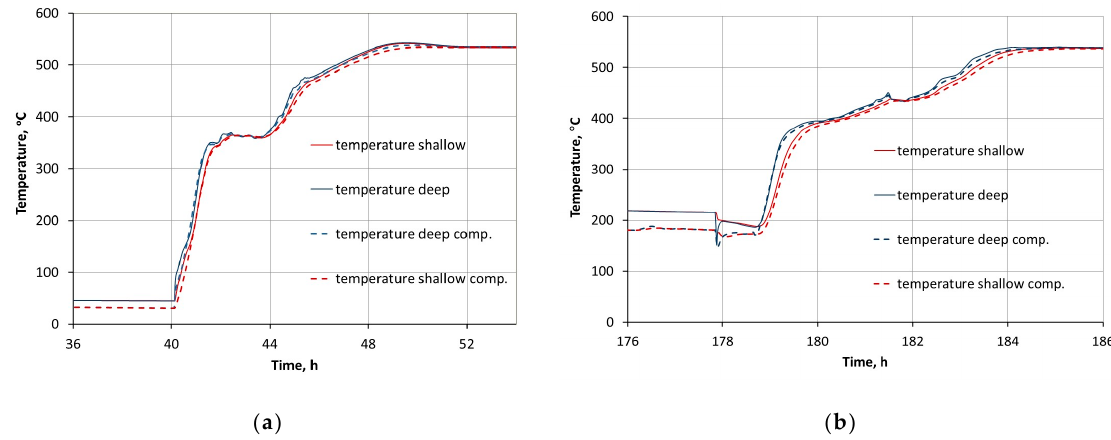
Figure 8. Comparison of temperature changes determined with the FEM and those measured at the selected points of the junction; calculations were made for a constant value of α = 1000 W/m 2 K: ( a ) startup from the cold state, ( b ) startup from the hot state.